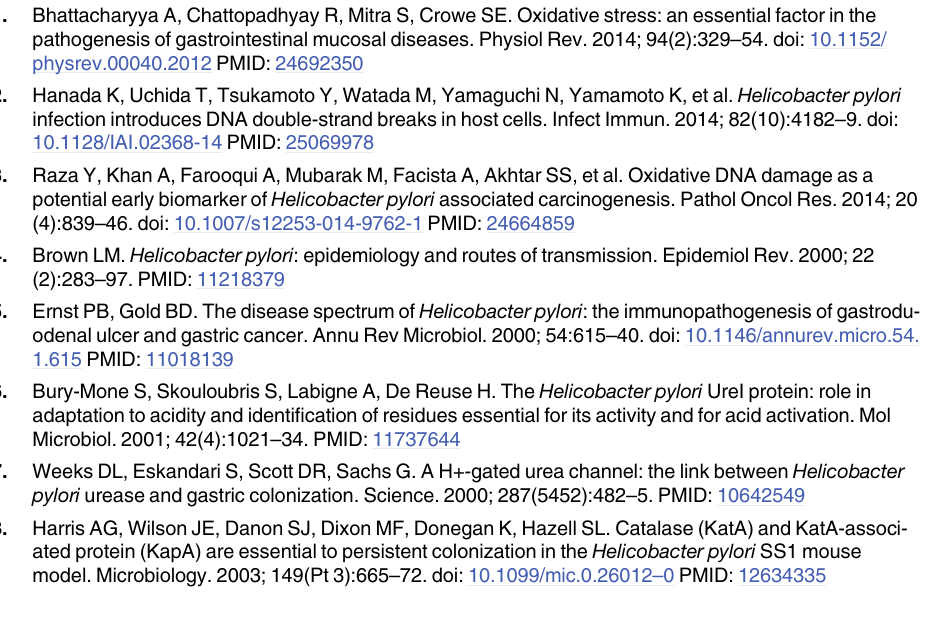
Figure B: Distribution of estimated area per λ molecule in periplasmic DNA foci of H . pylori . Figure C: Growth of competent H . pylori N6 in minimal medium without purine source